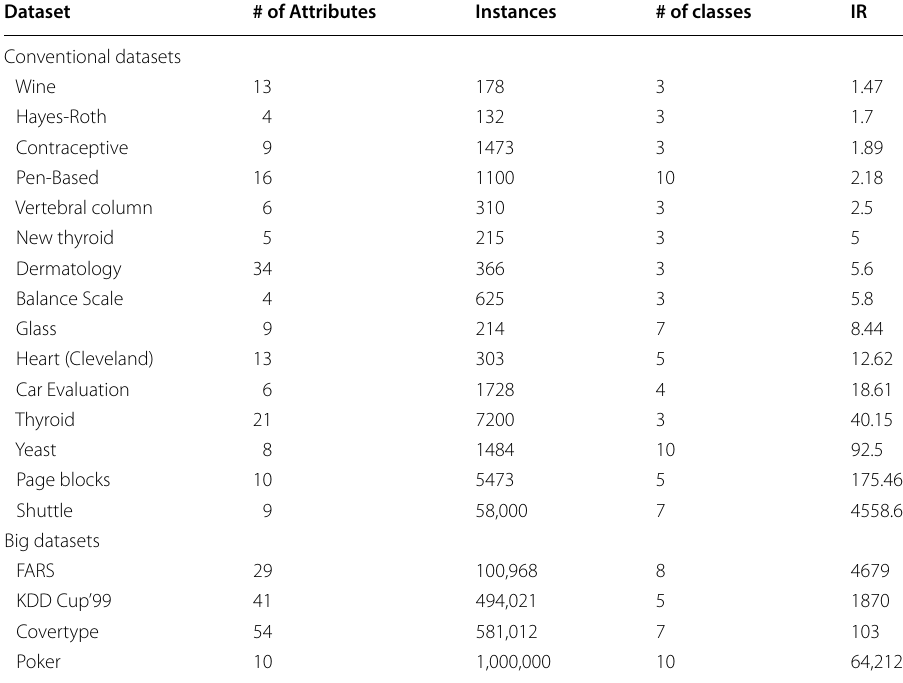
Table 2 Characteristics of the test datasets Dataset # of